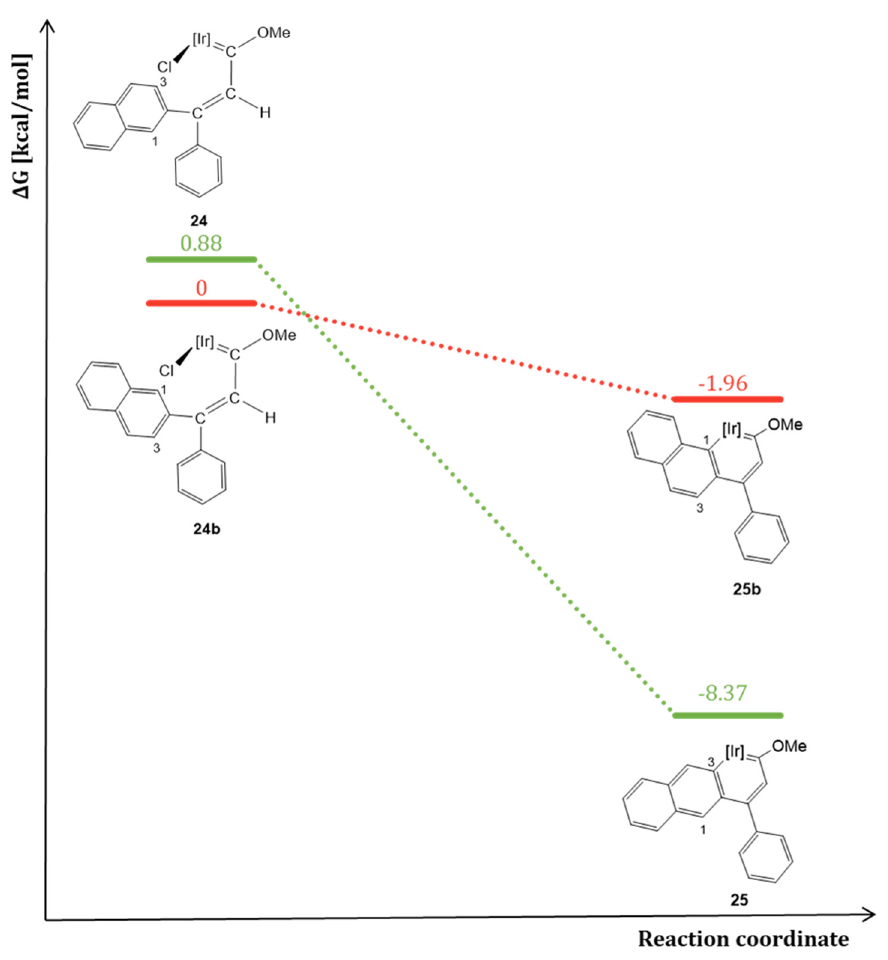
Figure 2. Energy profile for the formation of iridaanthracene complex 25 vs. iridaphenanthrene complex 25b [Ir] = [IrCp*(PMe 3 )]PF 6 .